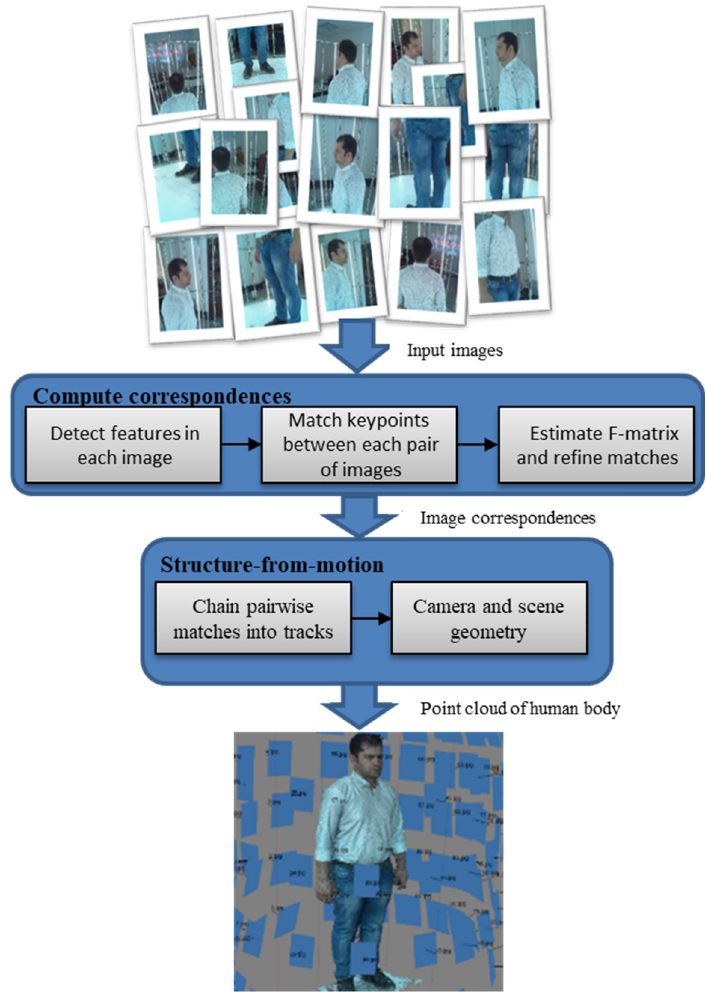
Figure 5. Block diagram of image processing in the 3D scanning system.